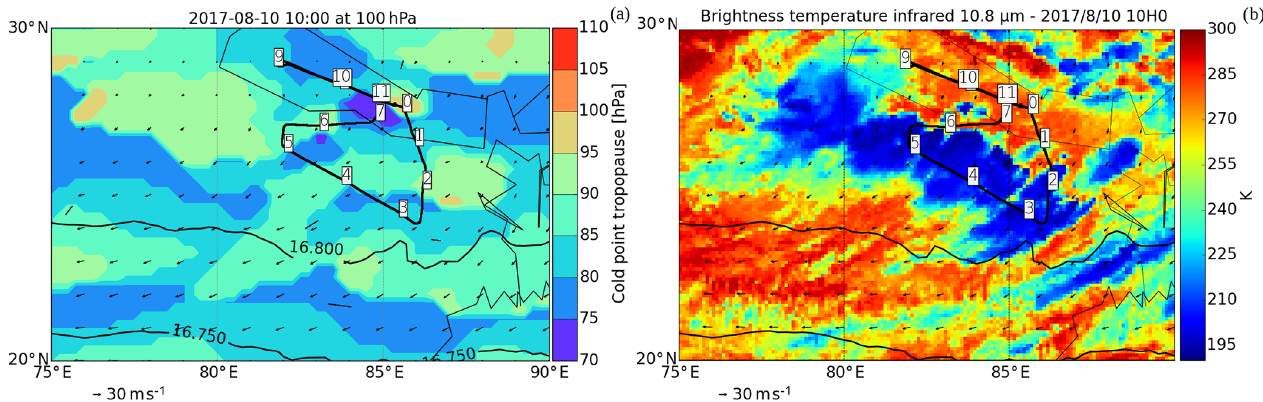
Figure 8. As in Fig. 6 but for F8 (10 August 2017) at 10:00UTC (around the middle of the flight).